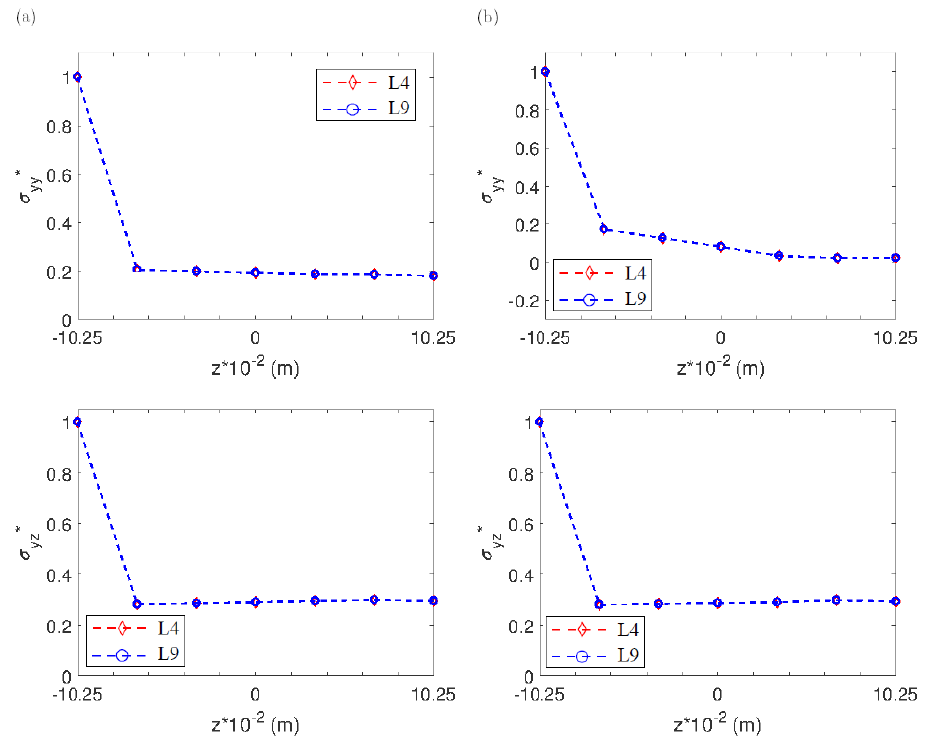
Figure 12. Distribution of axial and shear stress components for ( a ) P ∗ = − 3.3 − 4 and ( b ) P ∗ = − 2.95 − 3 loads in NL regime at L4 and L9 extensions at x = − a 2 /2 and y = L /2 in the single-cell FG beam subject to axial loading for m = 5.0; σ ∗ yy = σ yy / σ yy